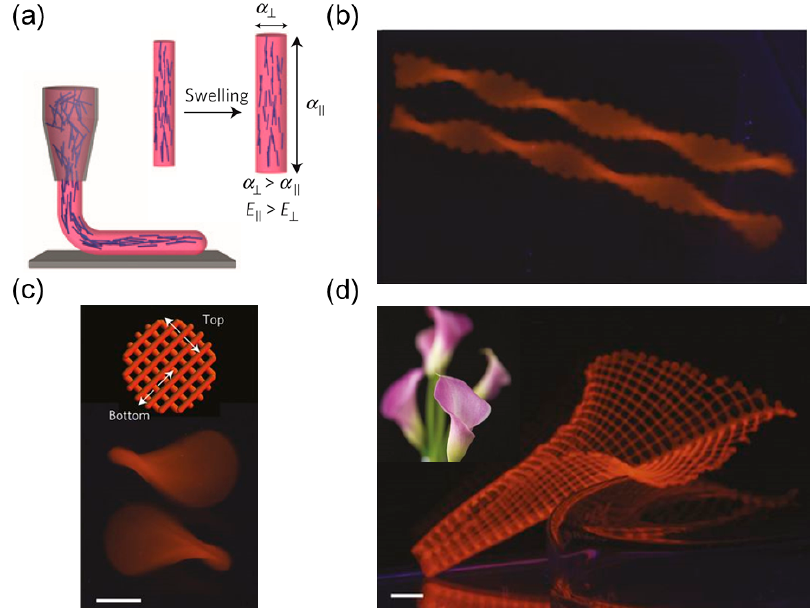
Figure 2. Humidity-responsive hydrogel-based helical structures mimicking Bauhinia variegata . ( a ) Shear-induced alignment of cellulose fibrils along the printed filament (left) and anisotropic swelling of the printed filament (right); ( b ) Helical shape generated by 4D-printed hydrogel; ( c ) Saddle shape (bottom) from orthogonal patterns of filaments in two layers (top), the scale bar is 2.5 mm; ( d ) Biomimetic lily flower from 4D-printed hydrogel, the inset is the lily flower in nature and the scale bar is 5 mm. ( a – d ) are from Ref. [26], reproduced with permission, copyright 2016 Nature Publishing Group.